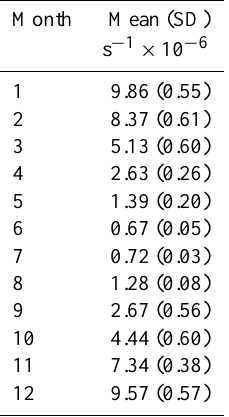
Table 1. Monthly mean photolysis rate J (O 1 D). This is calculated using hourly averages for each of the 24h in the day.